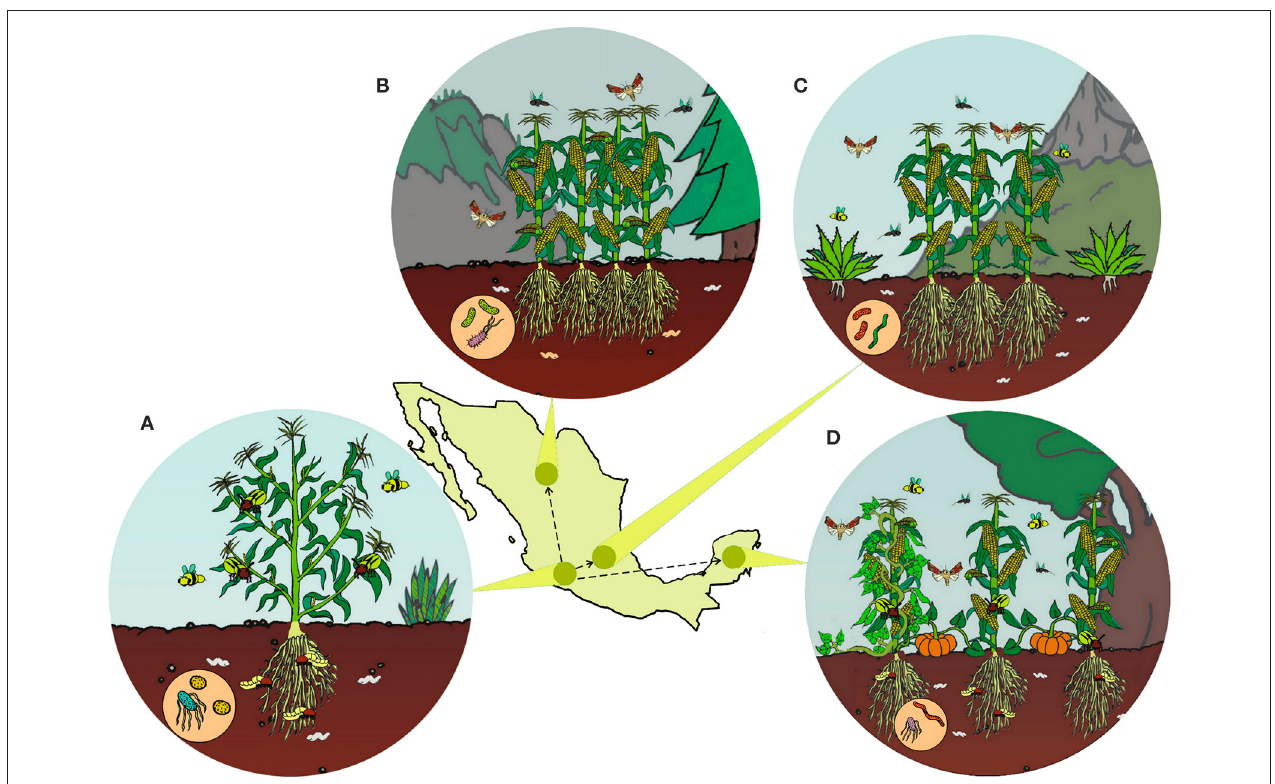
FIGURE 1 | Following the domestication of maize in Western Mexico (A) , maize was brought to new geographic regions (hypothetical routes shown by arrows). In the tropics (D) , highland (B) , and altiplano (C) environments, maize likely diversified as it experienced new climatic conditions, soils, cropping systems, biodiversity, and human